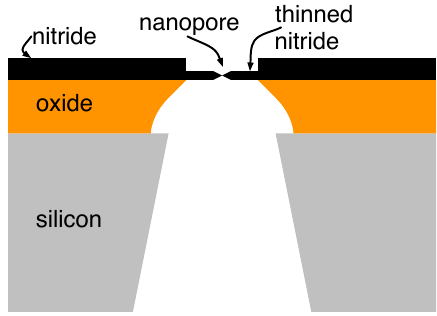
Figure 7. Cross-section of a typical solid-state nanopore and its support structure.